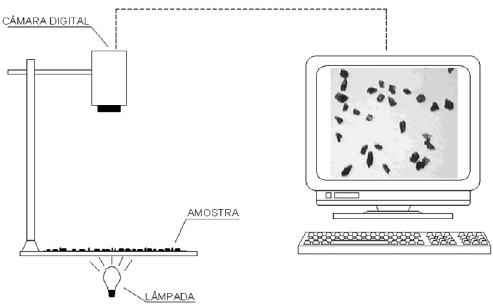
Figura 2. Esquema do aparato montado para fazer a aquisição das imagens das frações de areia mais finas.